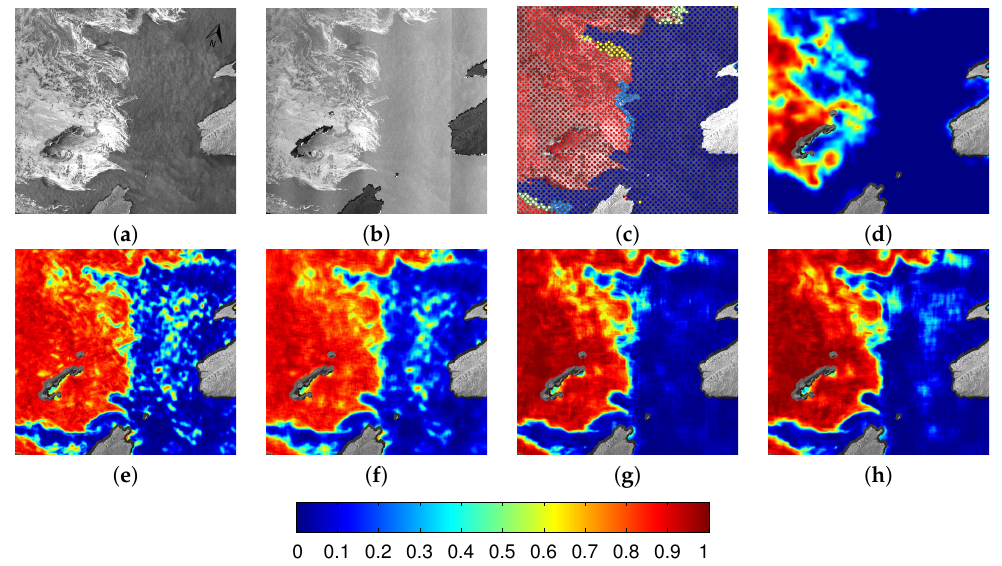
Figure 8. Visual comparison of different patch sizes, ( e ) 25 × 25 pixels, ( f ) 35 × 35 pixels, ( g ) 45 × 45 pixels, ( h ) 55 × 55 pixels. Estimate of ice concentration is improved when patch size increases. Patch size 45, corresponding to ground distance of 18 km, has cleaner water estimates than the others. Subscene of dimension 270 km × 270 km from 20140124_215646 centered at 47.86 ◦ N, 60.94 ◦ W. Panels ( a – d ) are the HH image, HV image, image analysis chart and ASI ice concentration